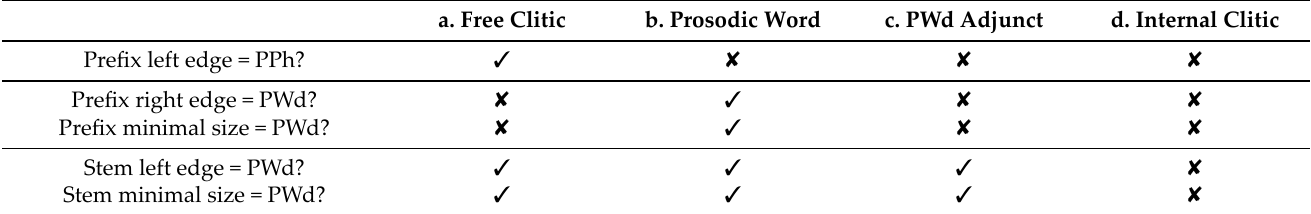
Table 6. Comparison of prefixes and PWd